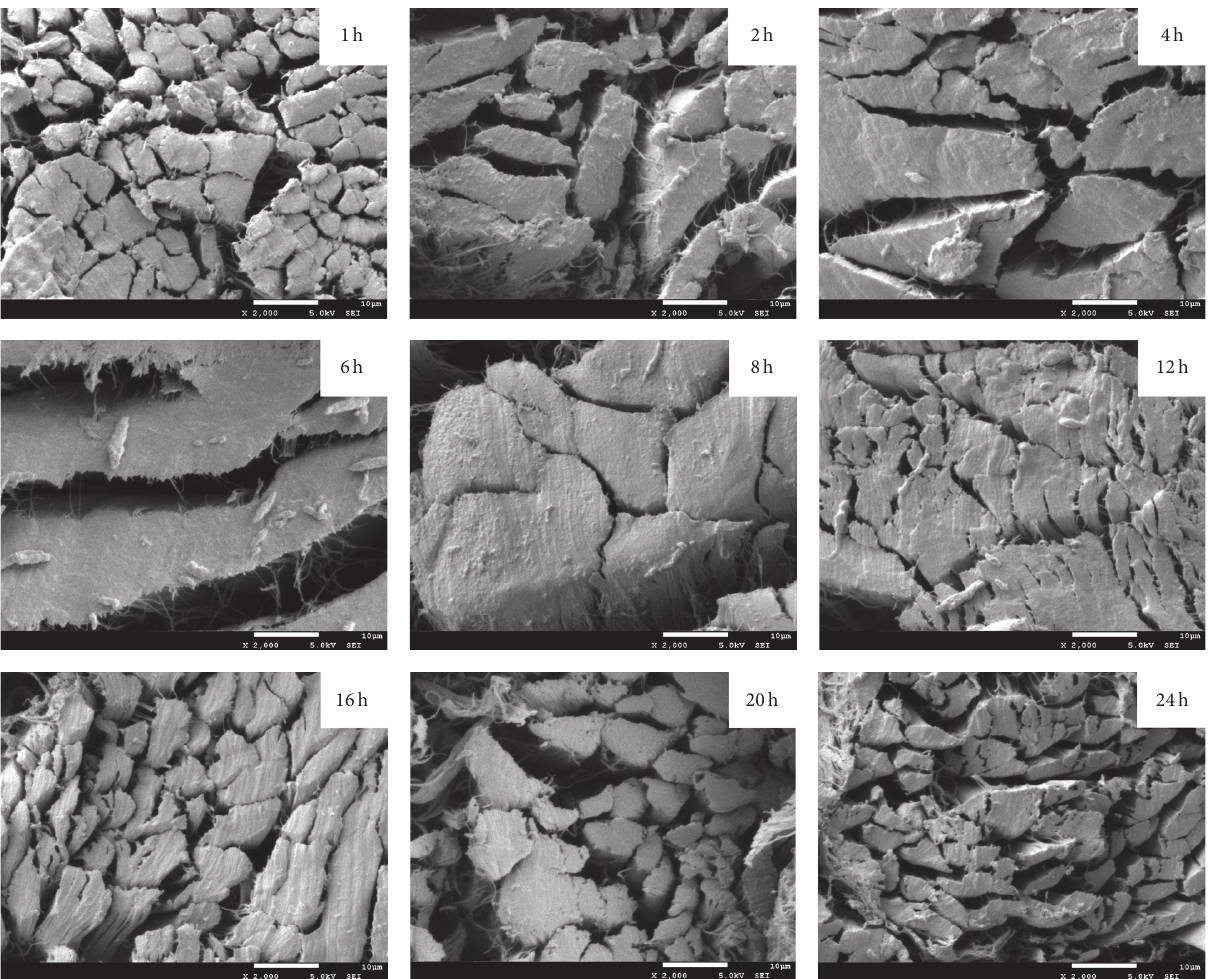
Figure 3: SEM photos of the cross-sections of the PnBMA/split composites ( × 2000).